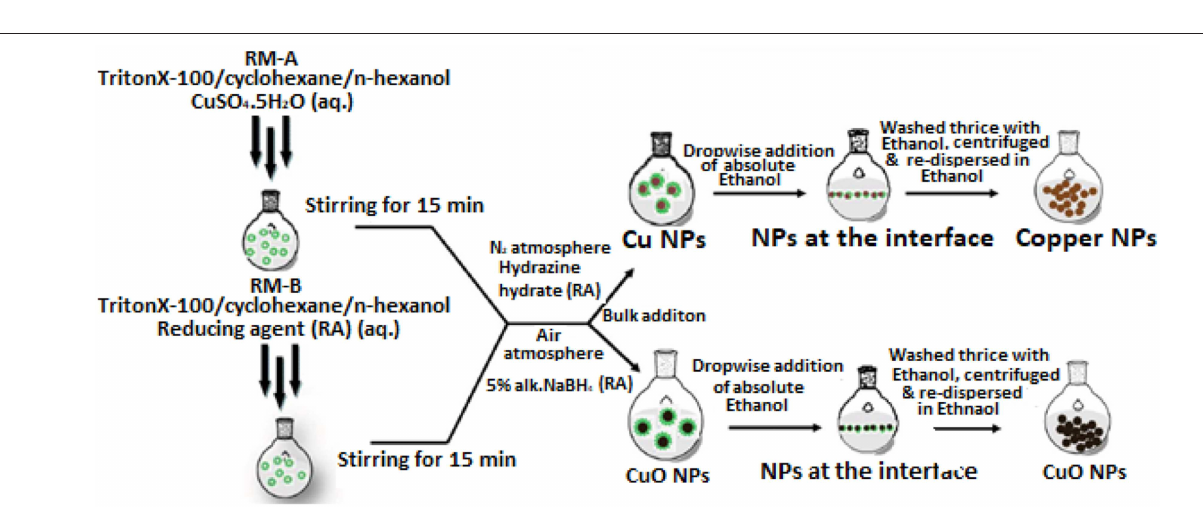
FIGURE 6 | Reverse phase microemulsion route for size-controlled synthesis of Cu and CuO nanoparticles [adapted and modified from Kumar et al. (2013) and Williams et al.